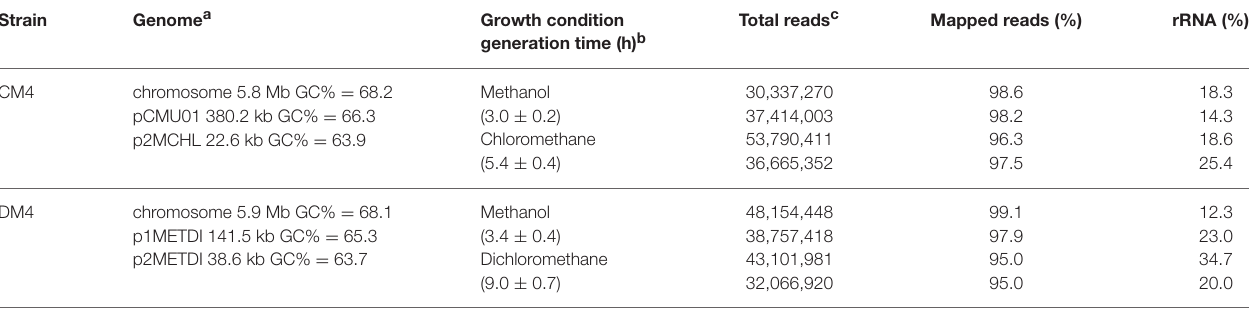
TABLE 1 | Overview of genomic properties of M. extorquens CM4 and DM4 and obtained RNA-Seq data. Strain Genome a